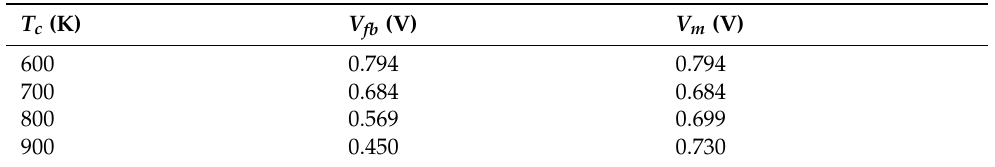
Table 1. At different temperatures, the flat-band voltage V fb and the output voltage V m . ( V m represents the output voltage at the maximum conversion